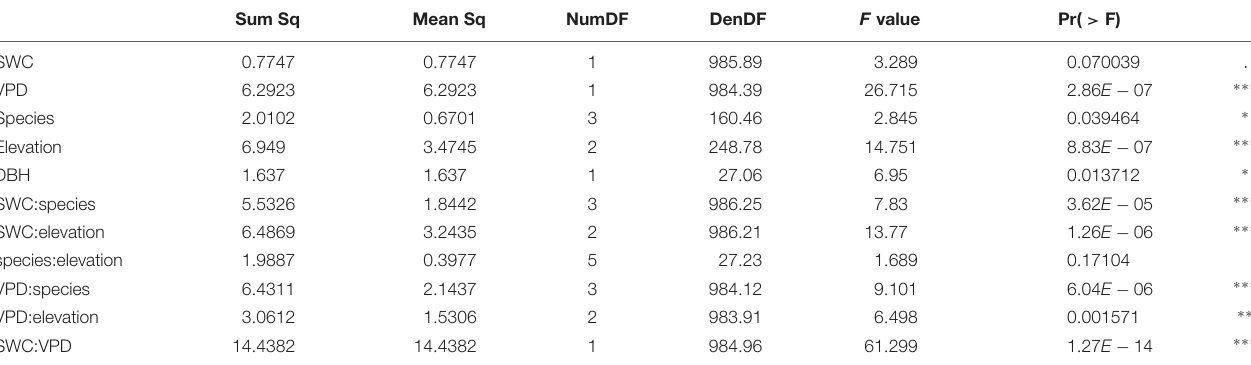
TABLE 4 | ANOVA table from mixed linear Model 1 (mixed effects model) with main effects of soil water content (SWC), vapor pressure deficit (VPD), species, elevation as fixed effects, tree size (DBH) as covariate, and species identity as random effect on daily sap flux density for the whole study period.